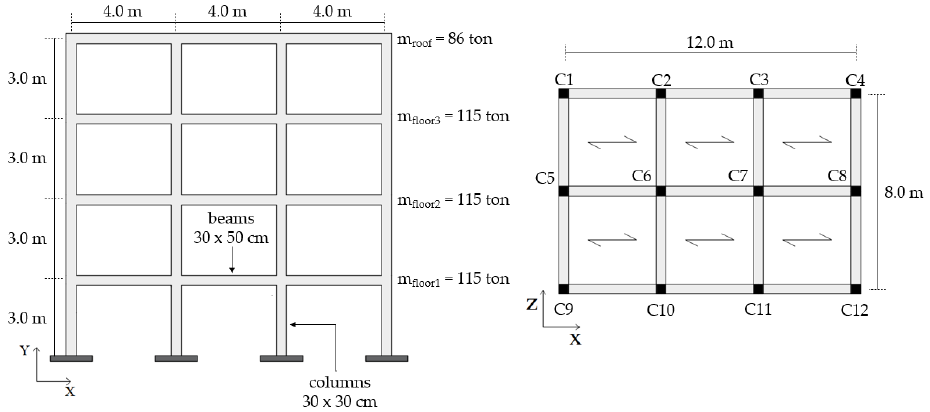
Figure 8. Elevation view and plan with the main dimensions of the RC case-study structure [9].